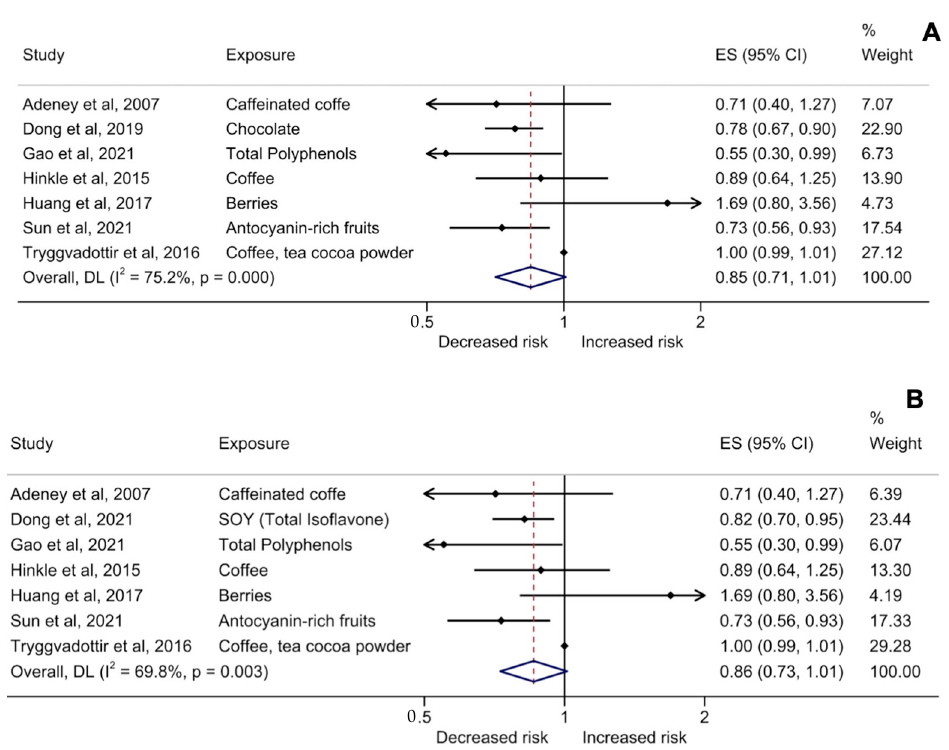
Figure 2. Forest plots for the pooled adjusted effect size of polyphenol-rich food consumption and risk for gestational diabetes mellitus in pregnant woman. Including Adeney et al., 2007 [24] , Hinkle et al., 2015 [25] , Tryggvadottir et al., 2016 [26] , Huang et al., 2017 [27] , Gao et al., 2021 [30] , Sun et al., 2021 [31] plus in (A) Dong et al. (2019) [28] with chocolate intake; or in ( B ) including Dong et al. (2021) [29] with total isoflavone intake. Both studies analysed the same population. Abbreviations: CI = confidence interval; ES = effect size.